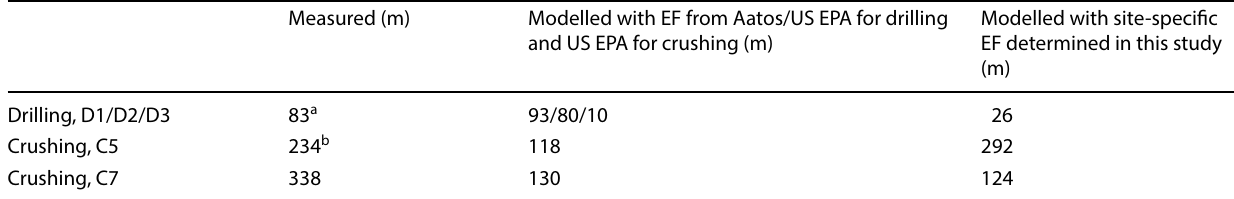
Table 6 Distances where background concentration is